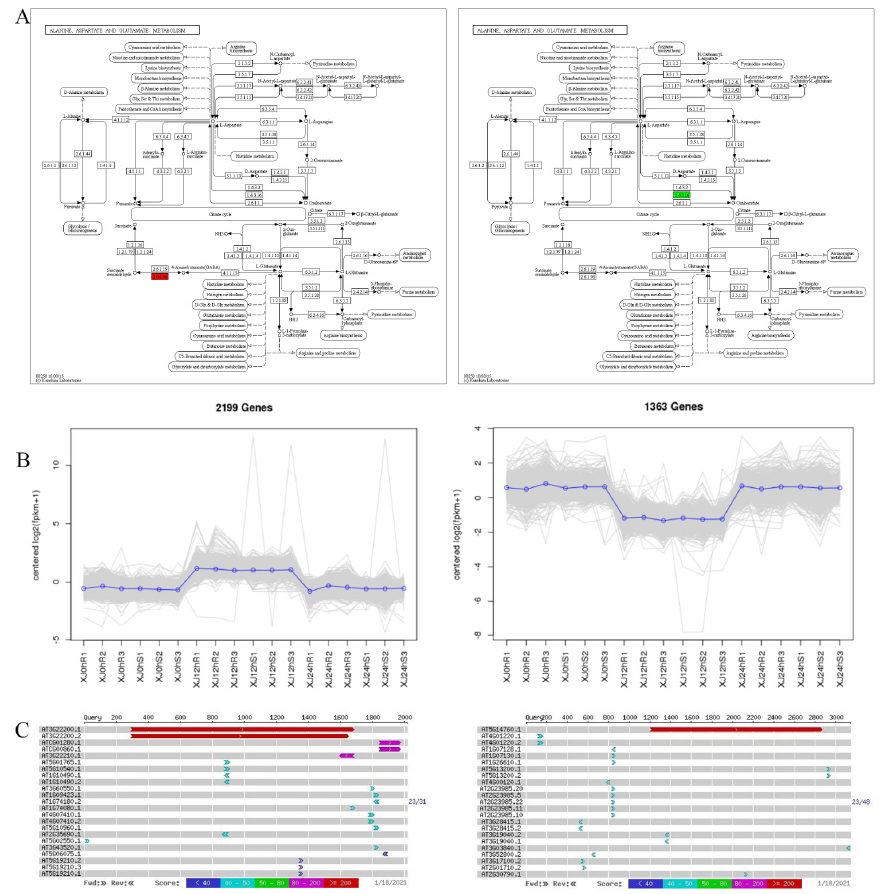
Figure 11. Drought-resistant gene screening. Note: ( A ) KEGG annotation path diagram. The number in the box is the EC number of the enzymes; the entire pathway is composed of a complex biochemical reaction catalysed by a variety of enzymes. In this pathway diagram, the enzymes related to differentially expressed genes are marked with different colours. ( B ) Gene co-expression trend graph. The abscissa represents the sample or time point, and the ordinate represents logarithmic centred expression levels. The grey line in the figure represents the expression trend of a gene. The blue line indicates the type of gene. ( C ) Gene sequence BLAST results.